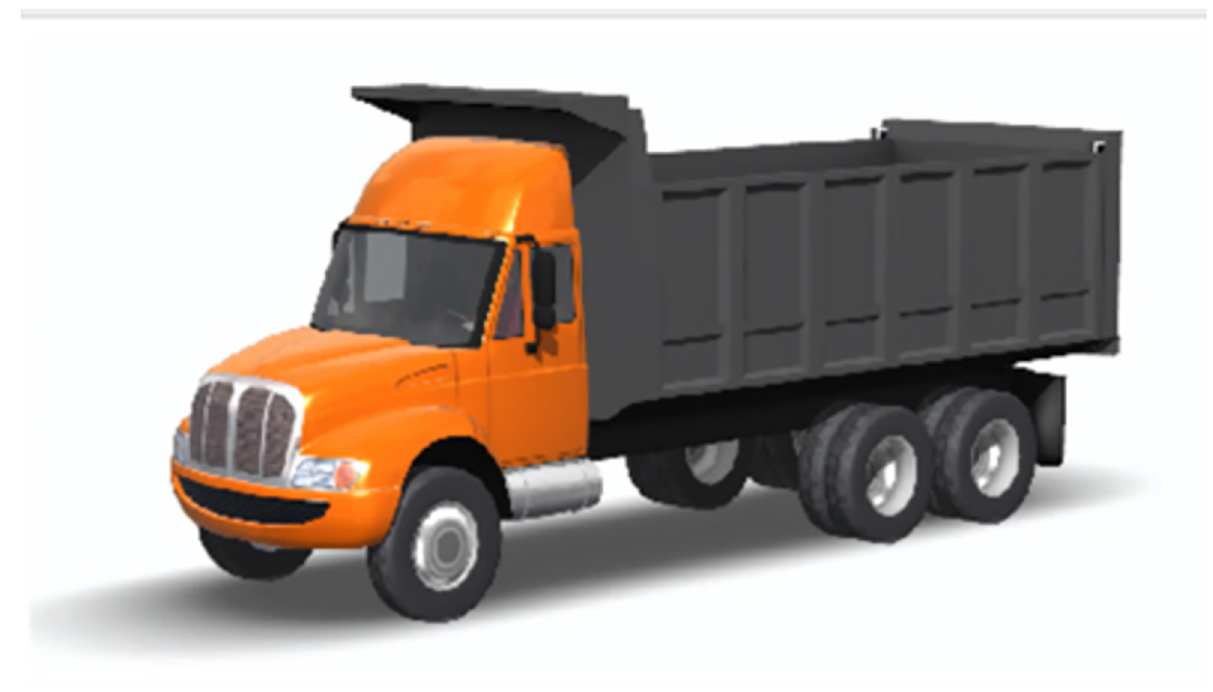
Fig 4. Simulation experimental